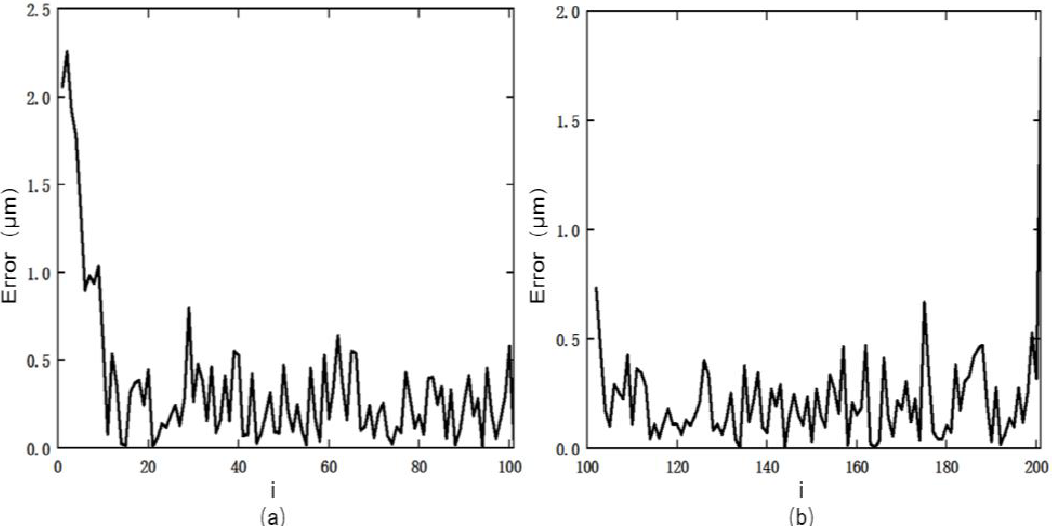
Figure 14. Signal fitting error plot (10 Hz): ( a ) ascending segment; ( b ) descending segment.